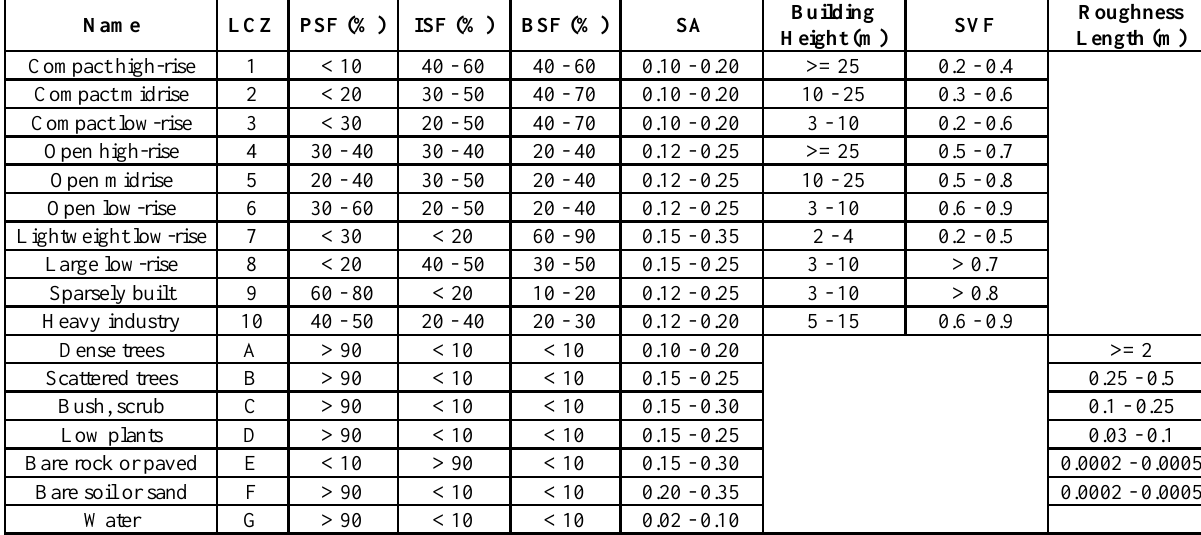
Table 2. Geometric, surface cover, and thermal properties of each LCZ